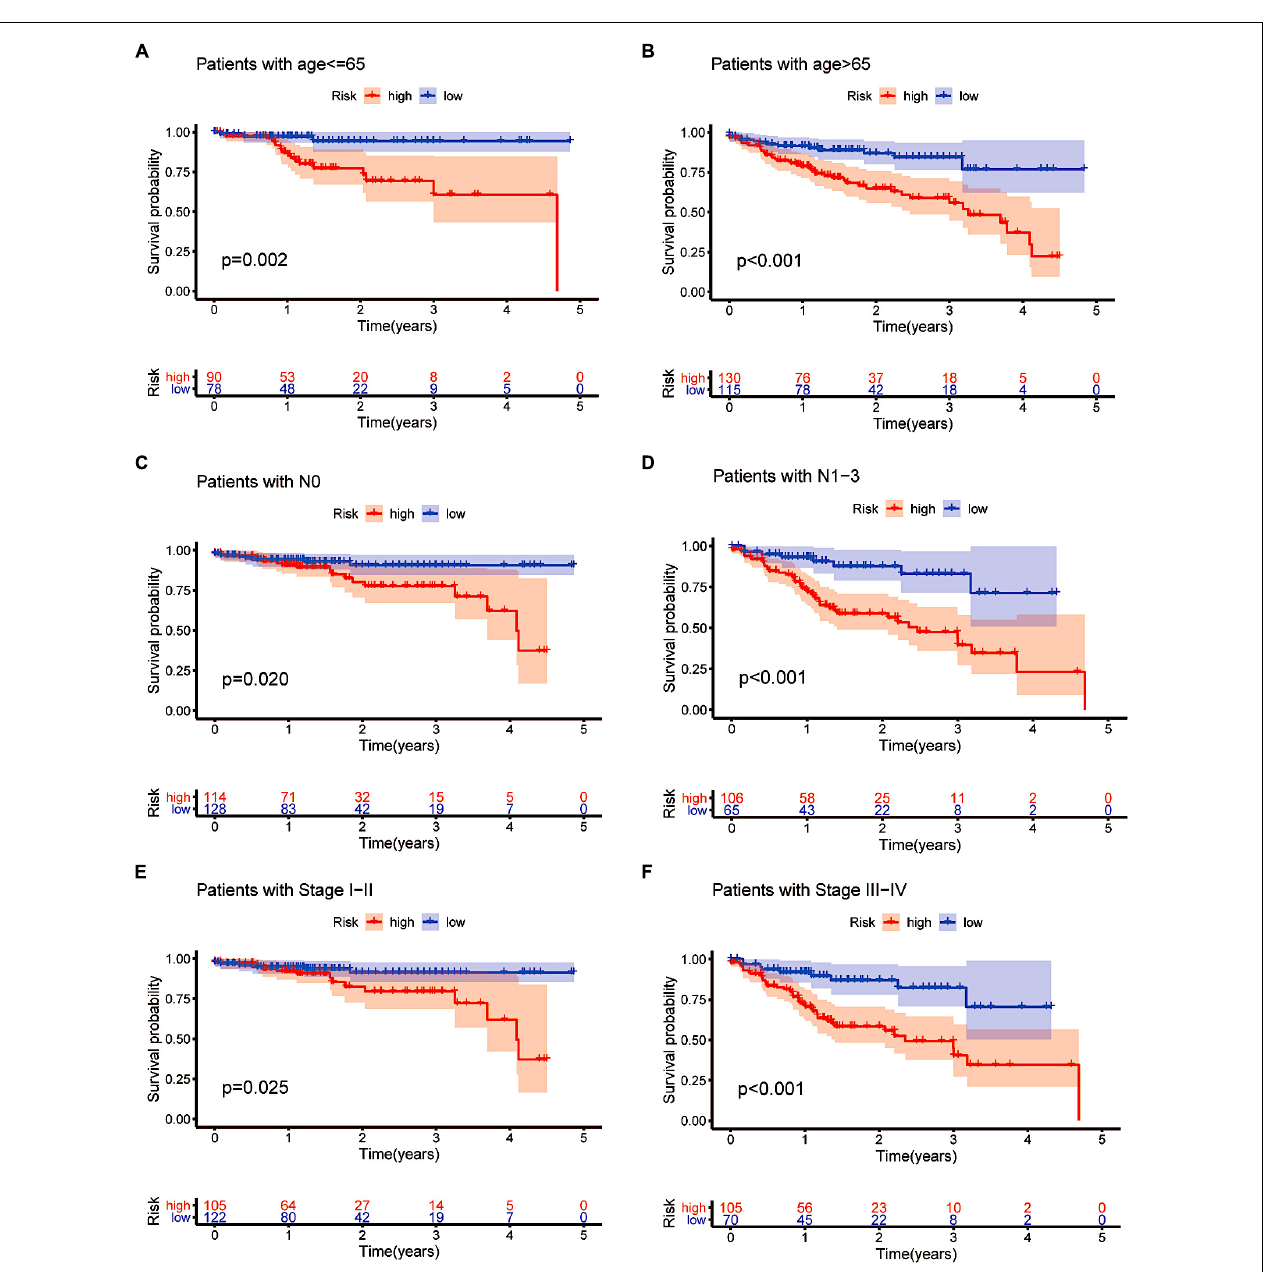
FIGURE 8 | Confirming the independence of the prognostic model. (A–F) The model we constructed based on the 16 m6A-related prognostic lncRNAs retained its prognostic value in multiple subgroups of CRC patients (including patients aged ≤ 65 or > 65 years, patients with N0 or N1-3 and patients with stages I–II or stages III–IV